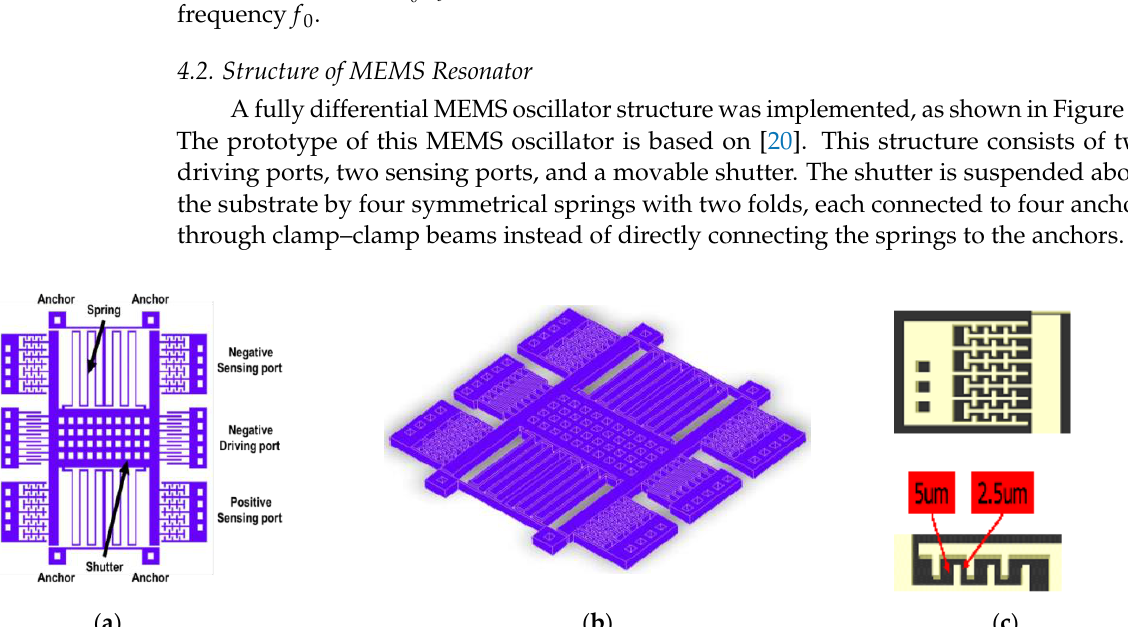
Table 2. Sizes of proposed differential MEMS oscillator.